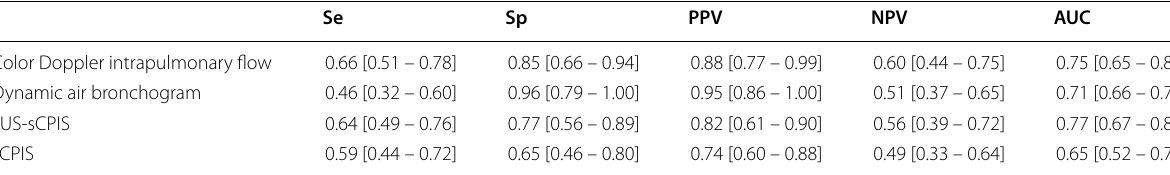
Table 3 Diagnostic accuracy of lung ultrasound signs